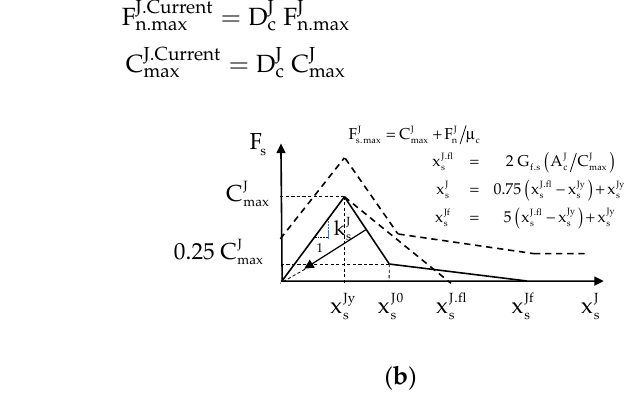
Figure 3. Bilinear softening contact model: ( a ) normal direction; ( b ) shear direction. If the adopted contact fracture energy is equal to the energy corresponding to the A local crack is considered to occur when the maximum possible damage (D J c = 1) is reached. At this stage, the local contact point is only considered to work under pure friction.